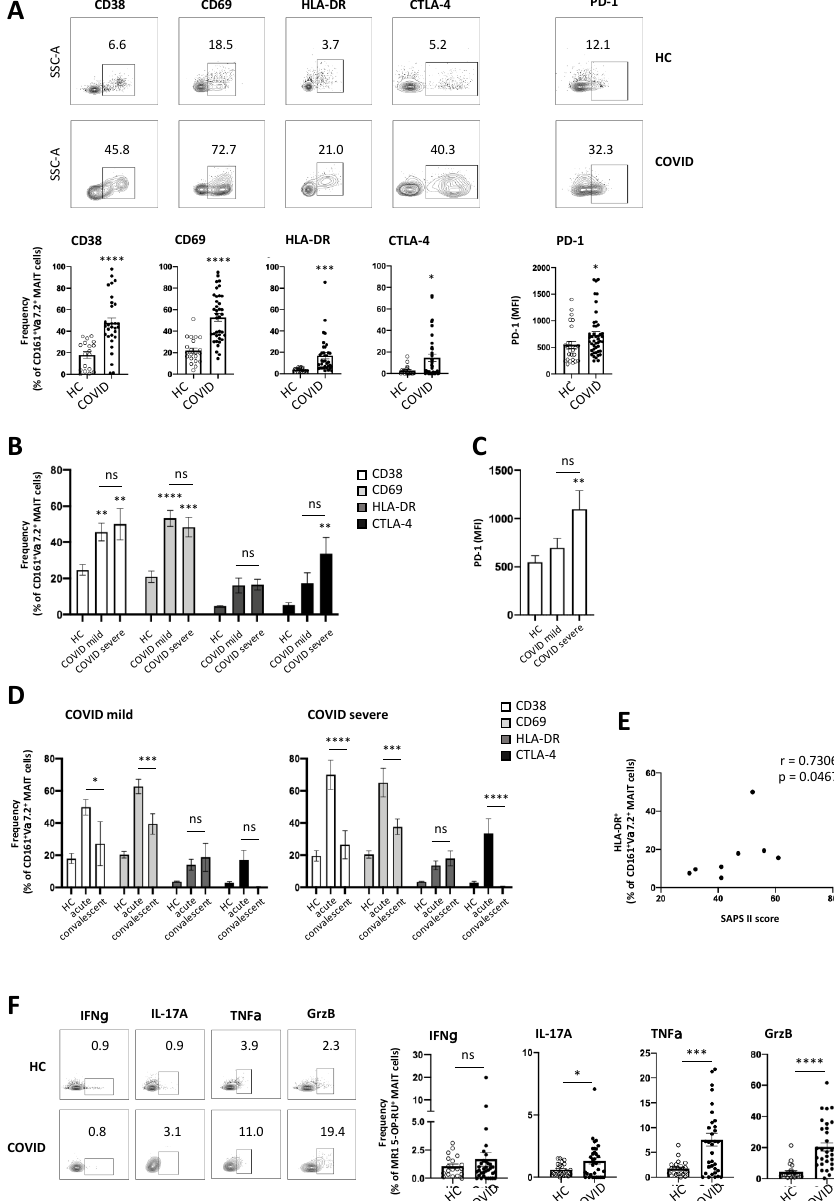
Figure 3. MAIT cells of COVID-19 patients express high levels of activation markers and cytokines ex vivo. ( A – D ) Ex vivo expression of surface activation markers in MAIT cells from peripheral blood of COVID-19 patients and healthy controls (HC); ( E ) Spearman correlation between expression of HLA-DR in MAIT cells in peripheral blood of COVID-19 patients and SAPS II score at day of sampling; ( F ) Ex vivo intracellular cytokine expression in MAIT cells from peripheral blood of COVID-19 patients and HC, representative data from one patient and summary data; ( A , E , F ) each symbol represents one patient. ( A ) CD38: HC n = 18 and COVID n = 30; CD69: HC n = 21 and COVID n = 38; HLA-DR: HC n = 21 and COVID = 35; CTLA-4: HC n = 20 and COVID n = 36; PD-1: HC n = 23 and COVID n = 34. ( B ) HC n = 13, COVID mild n = 22 and COVID severe n = 18; ( C ) HC n = 26, COVID mild n = 17 and COVID severe n = 9; ( D ) HC n = 19, COVID acute n = 13 and COVID convalescent n = 9; ( E ) n = 8; ( F ) IFN γ : HC n = 19 and COVID n = 33; IL-17A: HC n = 23 and COVID n = 33; TNF α : HC n = 23 and COVID n = 34; GrzB: HC n = 23 and COVID n = 34. Data are presented as mean ± SEM and were pooled from six ( A – D ) or four ( E ) independent experiments; * p < 0.05, ** p < 0.01, *** p < 0.001 and **** p < 0.0001 vs. HC or as indicated. Data were assessed using unpaired t-test ( A , F ), two-way analysis of variance (ANOVA) with Tukey’s multiple comparisons test ( B , D ) or one-way ANOVA with Tukey’s multiple comparisons test ( C ). ns = not